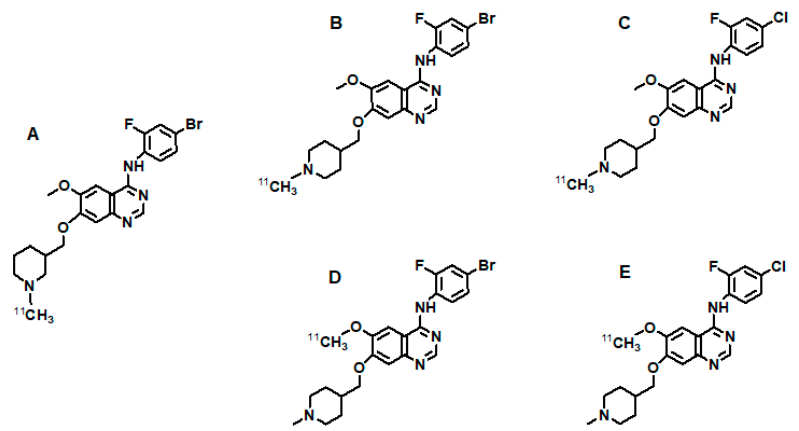
Figure Figure 5. Vandetanib-based VEGFR imaging agents; ( A ): [ N-methyl- 11 C]-PAQ [43]; ( B ): [ N-methyl- 11